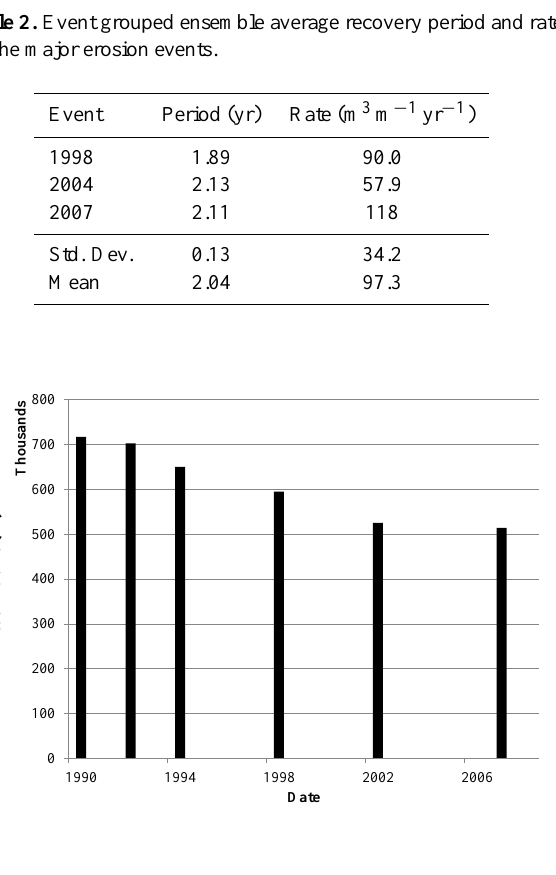
Fig. 8. The Bluff Block (BR6 – BR10) average pre-erosion event